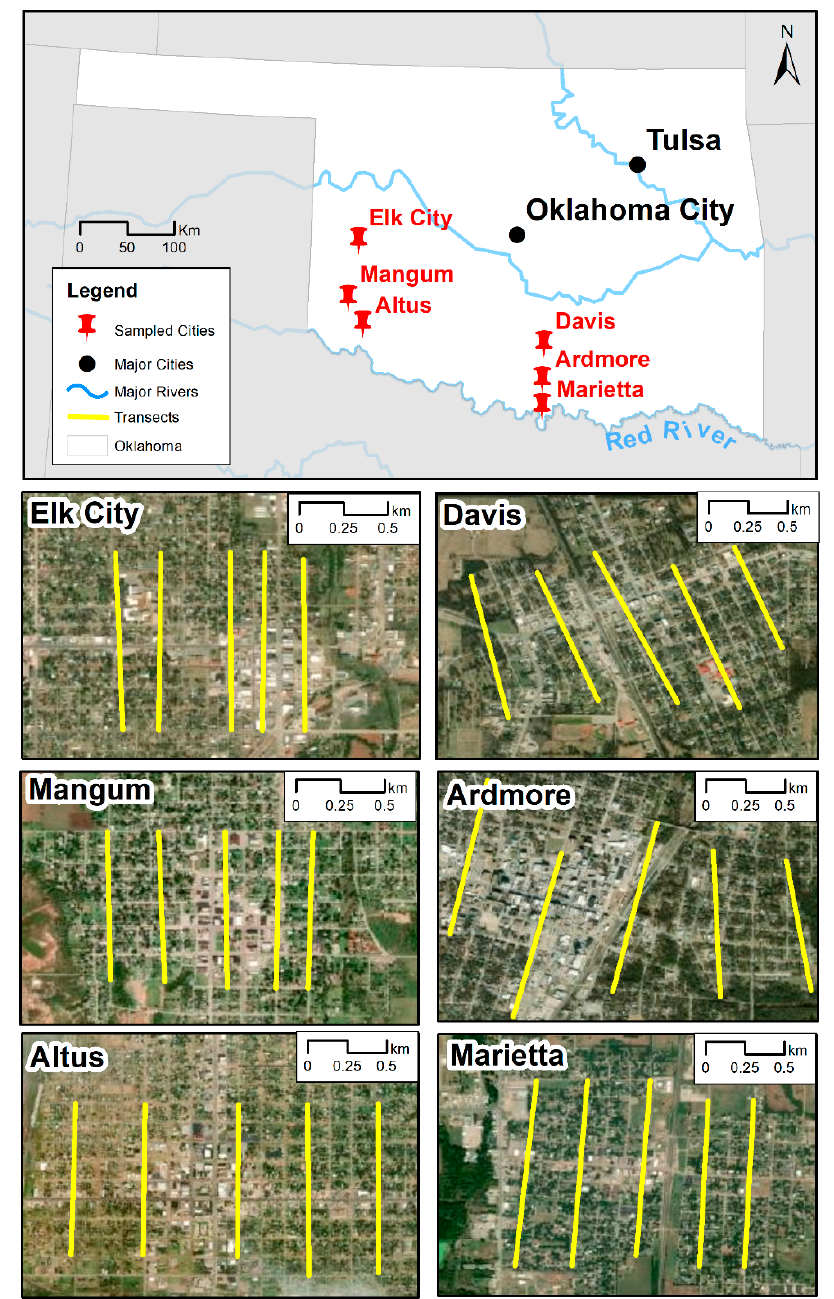
Figure 1. The six urban clusters in Oklahoma where mosquito collections were carried out between June and August 2017. The five transects in each city along which Gravid Aedes traps (GAT) were placed are provided.